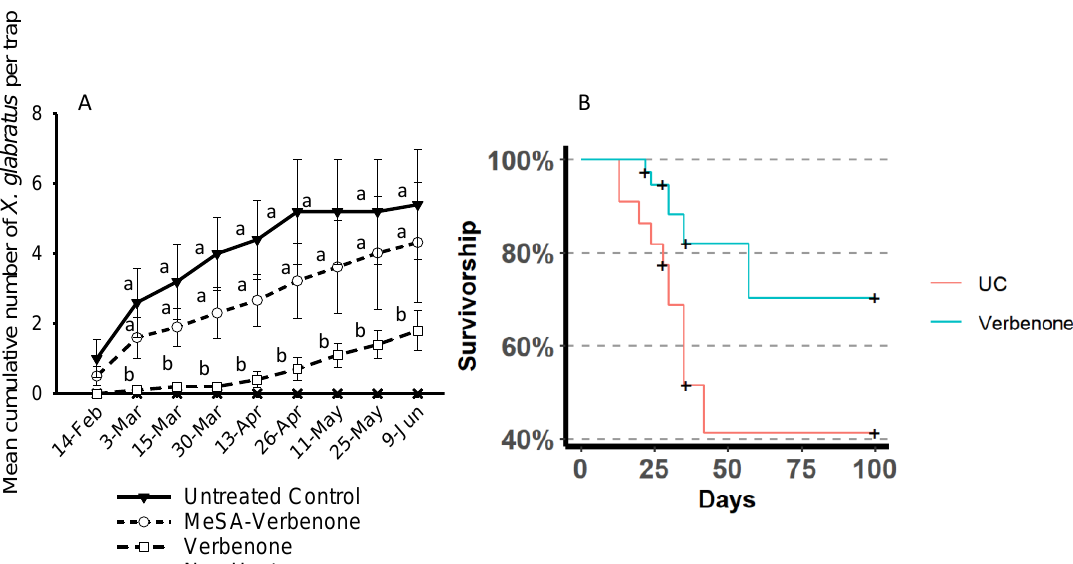
Figure 4. ( A ) : Mean (±SE) of cumulative capture of Xyleborus glabratus during field trials in Wakulla Spring State Park (FL), following a single application of verbenone and a mixture of verbenone and methyl salicylate (MeSA-Verbenone). Points labeled by different lower-case letters within treatments are significantly different at the p < 0.05 level for the given date. From Martini et al. (2020). ( B ) Cumulated survivorship of redbay and swamp bay trees treated with verbenone on four different studies in Wakulla State Park, Ichetucknee Springs State Park, Historic Hail Homestead Lake and Lake Talquin State Park (FL), conducted from 2017 to 2018. UC (untreated control) and verbenone treatment differed significantly at the p < 0.05. Crosses indicate censured data.